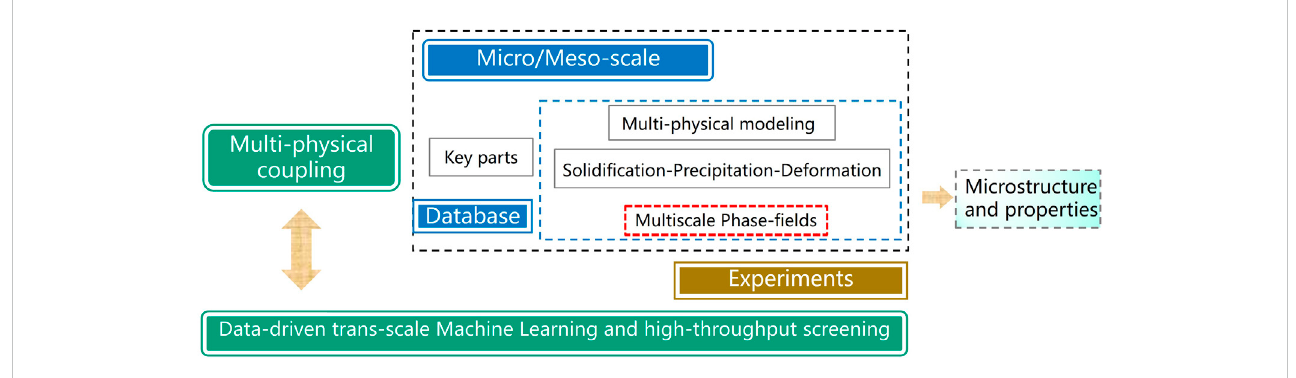
FIGURE 1 The design schematic of metallic materials processes in the PFM-ICME